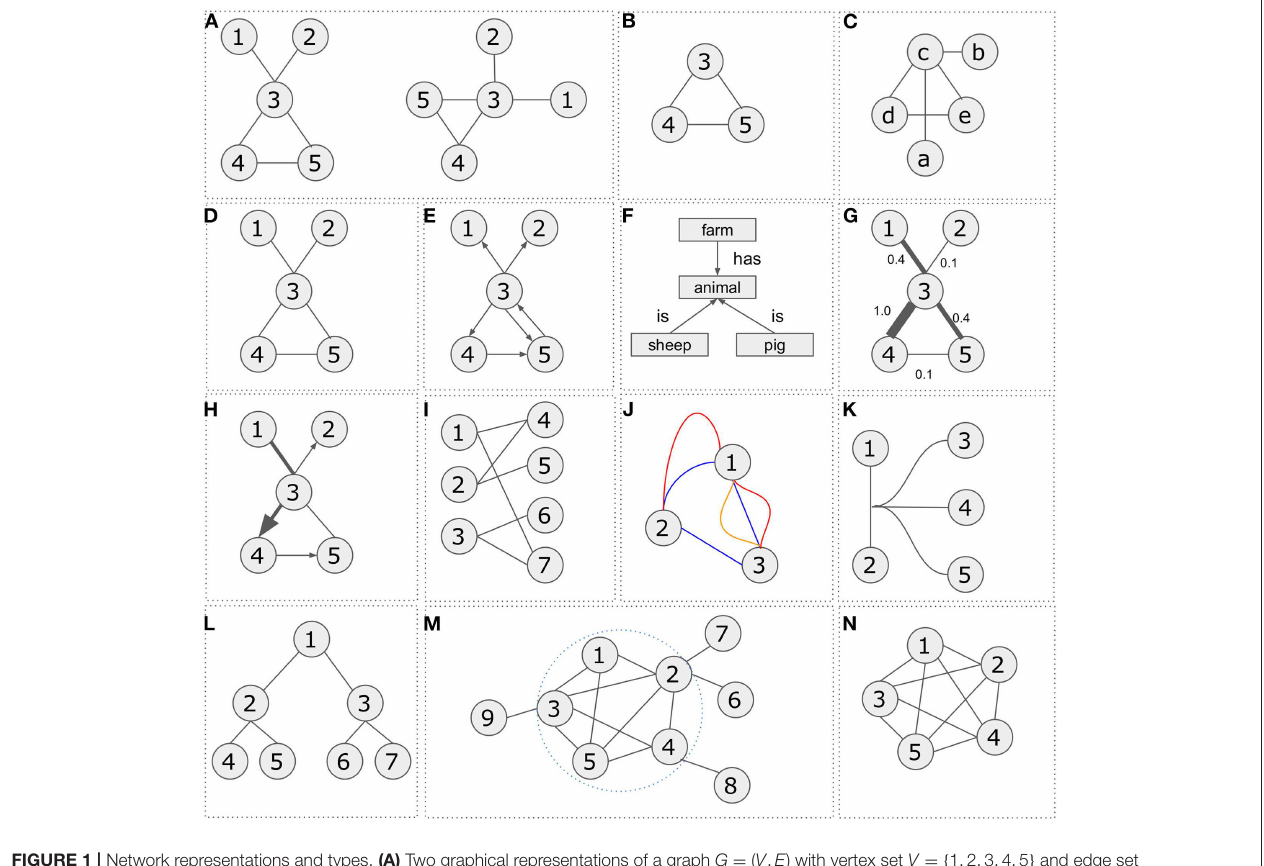
FIGURE 1 | Network representations and types. (A) Two graphical representations of a graph G = ( V , E ) with vertex set V = { 1,2,3,4,5 } and edge set E = {{ 1,3 } , { 2,3 } , { 3,4 } , { 3,5 } , { 4,5 }} . (B) Representation of subgraph G ′ = ( V ′ , E ′ ) with vertex set V = { 3,4,5 } and edge set E = {{ 3,4 } , { 3,5 } , { 4,5 }} . (C) Graph G ′′ = ( V ′′ , E ′′ ) is isomorphic to graph G = ( V , E ) with vertex set V = { a , b , c , d , e } and edge set E = {{ a , c } , { b , c } , { c , d } , { c , e } , { d , e }} . (D) Undirected graph G = ( V , E ) with vertex set V = { 1,2,3,4,5 } and edge set E = {{ 1,3 } , { 2,3 } , { 3,4 } , { 3,5 } , { 4,5 }} . (E) Directed graph G = ( V , E ) with vertex set V = { 1,2,3,4,5 } and edge set E = {{ 3,1 } , { 3,2 } , { 3,4 } , { 4,5 } , { 3,5 } , { 5,3 }} . (F) Semantic graph. (G) Weighted graph G = ( V , E ) with vertex set V = { 1,2,3,4,5 } and edge set E = {{ 3,1,0.4 } , { 3,2,0.1 } , { 3,4,1.0 } , { 4,5,0.1 } , { 3,5,0.4 }} . (H) Mixed graph G = ( V , E ) with vertex set V = { 1,2,3,4,5 } and edge set E = {{ 1,3 } , { 3,2 } , { 3,4 } , { 5,3 } , { 4,5 }} . (I) Bipartite graph with vertex set V ′ = { 1,2,3 } , V ′′ = { 4,5,6,7 } and edge set E = {{ 1,4 } , { 1,7 } , { 2,4 } , { 2,5 } , { 3,6 } , { 3,7 }} . (J) Multi-edge graph G = ( V , E ) with vertex set V = { 1,2,3 } and three different types of edge sets E ′ = {{ 1,2 } , { 2,3 } , { 3,1 }} , E ′′ = {{ 1,2 } , { 1,3 }} , E ′′′ = {{ 1,3 }} . (K) Hypergraph G = ( V , E ) with vertex set V = { 1,2,3,4,5 } and an edge connecting multiple nodes E = {{ 1,2,3,4,5 }} . (L) A tree graph G = ( V , E ) with vertex set V = { 1,2,3,4,5,6,7 } and edge set E = {{ 1,2 } , { 2,4 } , { 2,5 } , { 1,3 } , { 3,6 } , { 3,7 }} . (M) A graph G = ( V , E ) with vertex set V = { 1,2,3,4,5,6,7,8,9 } and edge set E = {{ 1,2 } , { 1,3 } , { 1,5 } , { 2,3 } , { 2,4 } , { 2,5 } , { 2,6 } , { 2,7 } , { 3,4 } , { 3,5 } , { 3,9 } , { 4,5 } , { 4,8 }} . A cluster consisting of nodes V = { 1,2,3,4,5 } and edges E = {{ 1,2 } , { 1,3 } , { 1,5 } , { 2,3 } , { 2,4 } , { 2,5 } , { 3,4 } , { 3,5 } , { 4,5 }} . (N) A five-node clique on the right. Any node is connected with any other